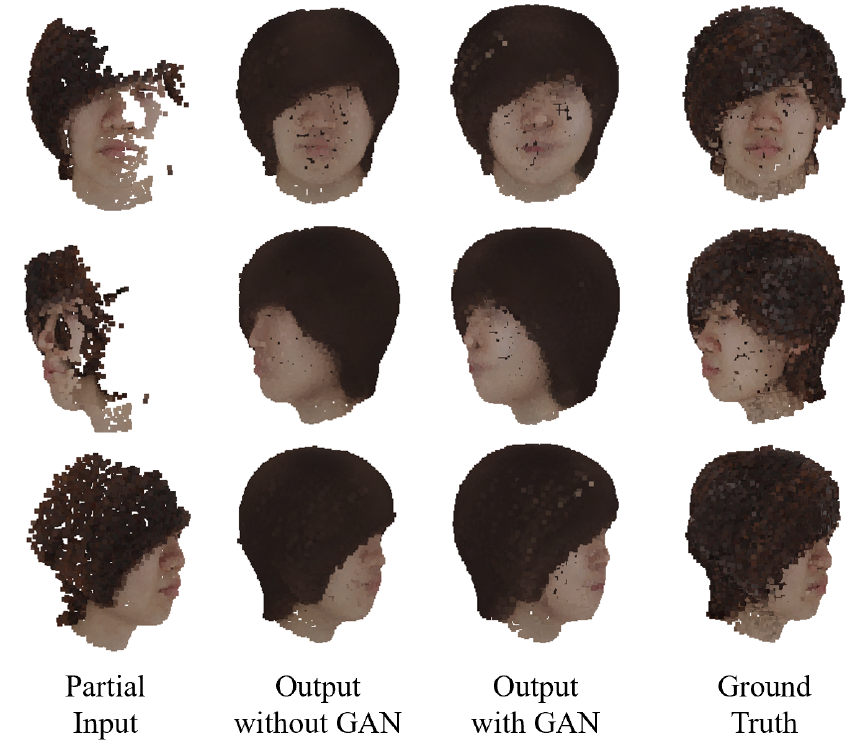
Figure 9. Completion example 2 using the proposed network.